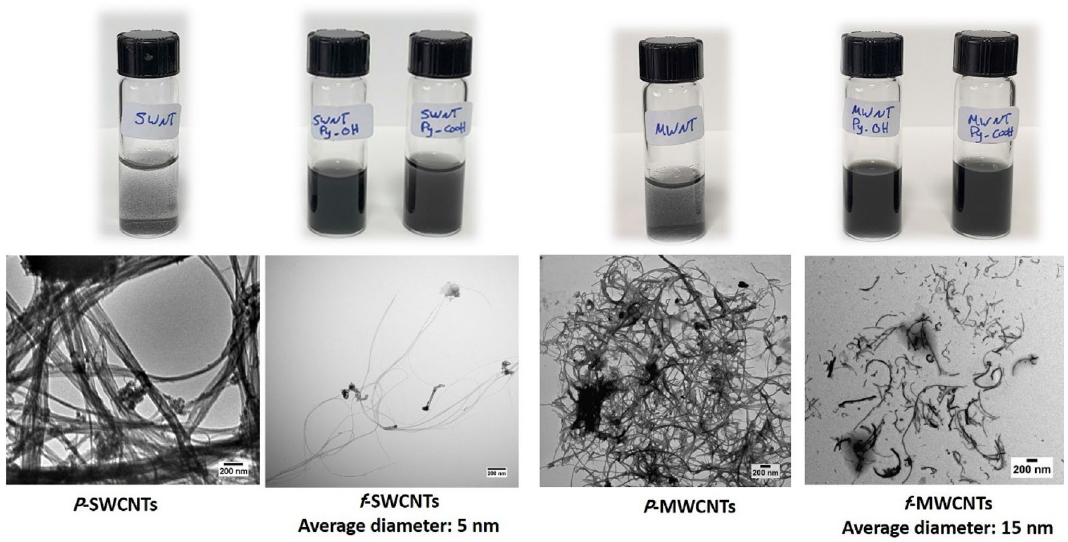
Figure 5. Vial photographs of pristine SWCNTs ( P -SWCNTs); functionalized SWCNTs (SWCNTs-Py-OH and SWCNTs-Py-COOH); pristine MWCNTs (P-MWCNTs); functionalized MWCNTs (MWCNTs-Py-OH and